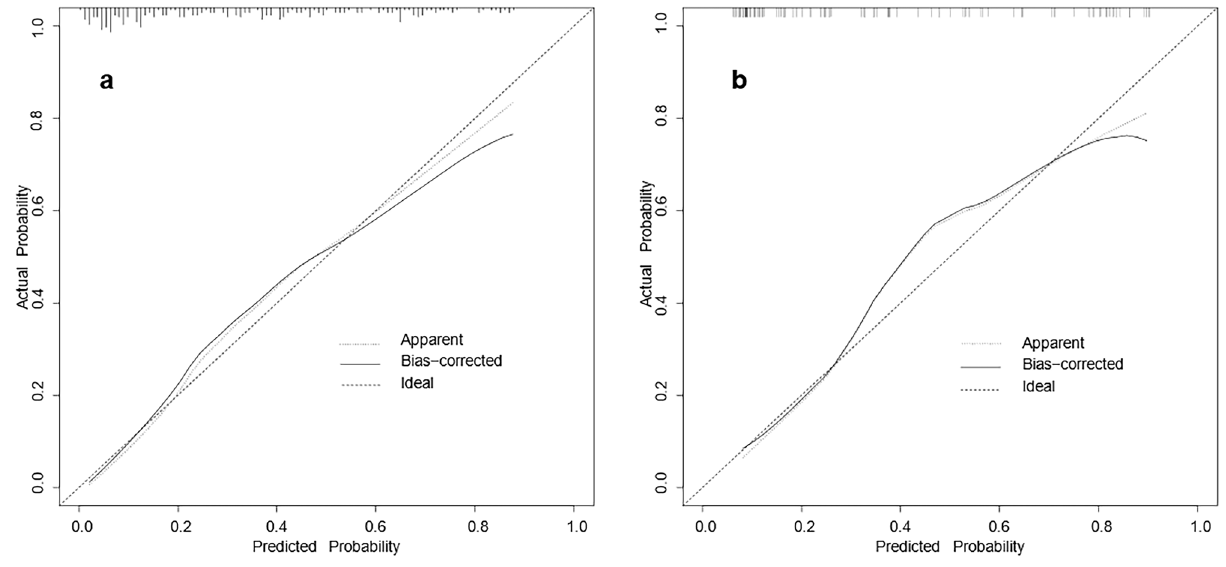
Figure 2. Calibration curves for the nomogram model of MPP in adults (( a ) training set, ( b ) validation set). The x-axis represents the probability of MPP in adults predicted by the nomogram; the y-axis represents the actual outcome. The diagonal dashed line represents the ideal prediction using the ideal model; the solid black line represents the nomogram model calibration curve. The calibration curve close to the diagonal dashed line indicates good agreement between the predicted and actual probabilities.